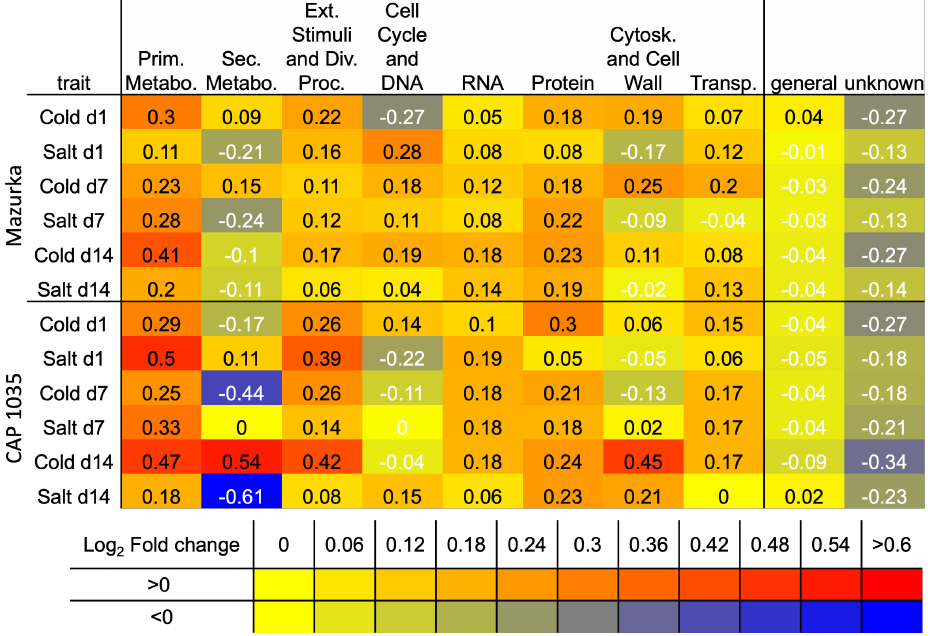
Figure 5. HeatMap of functional characteristics in significant modules of WGCNA for both species. Co-expression analysis (WGCNA, Ref. [66]) was performed for both transcriptomes individually with all samples from harvest time point as indicated. Within the significant modules, all genes were characterized and summarized according to their biological function of indicated Mercator bins [71]. Afterwards, the log2 (fold change) of significant genes between sample and control were calculated. Values > | 0.25 | were considered to be